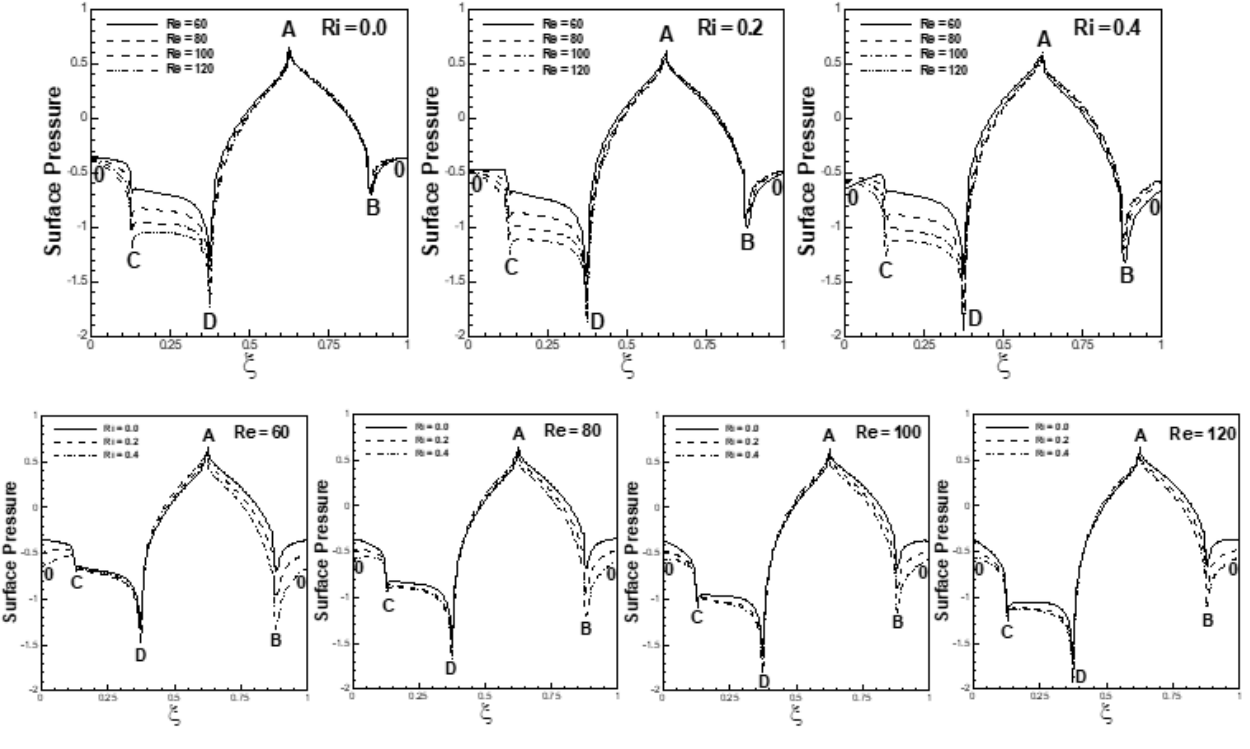
Figure 22. Mean surface pressure profiles at 60 ≤ Re ≤ 120, 0 ≤ Ri ≤ 0.4 and α = 45 ◦ . Table 2. Mean lift and drag coefficients, Strouhal number (St) and mean Nusselt number (Nu) for 40 ≤ Re ≤ 120, 0 ◦ ≤ α ≤ 60 ◦ and 0 ≤ Ri ≤